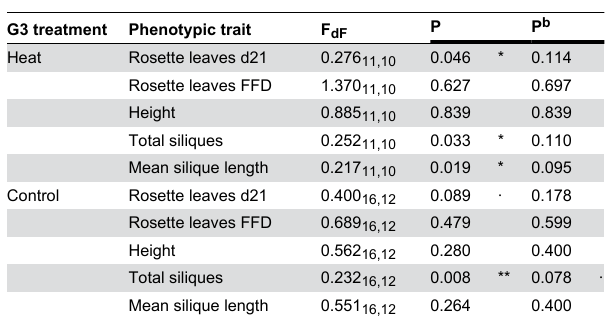
Table 3. Effect of two generations of heat treatment (G1 and G2) vs two generations of control treatment on variances of traits measured under G3 heat and control conditions in genotype